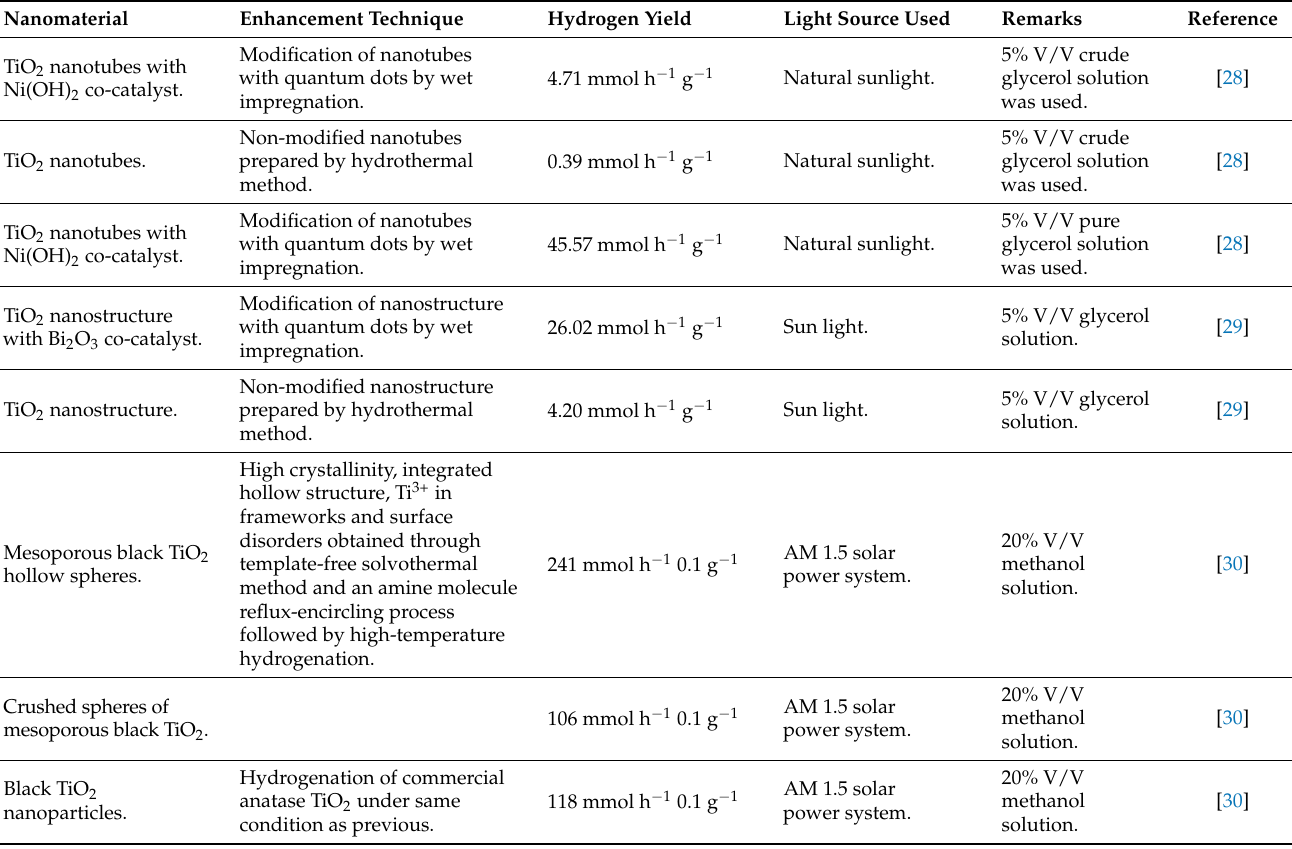
Table 1. Summary of Titanium-related photocatalytic